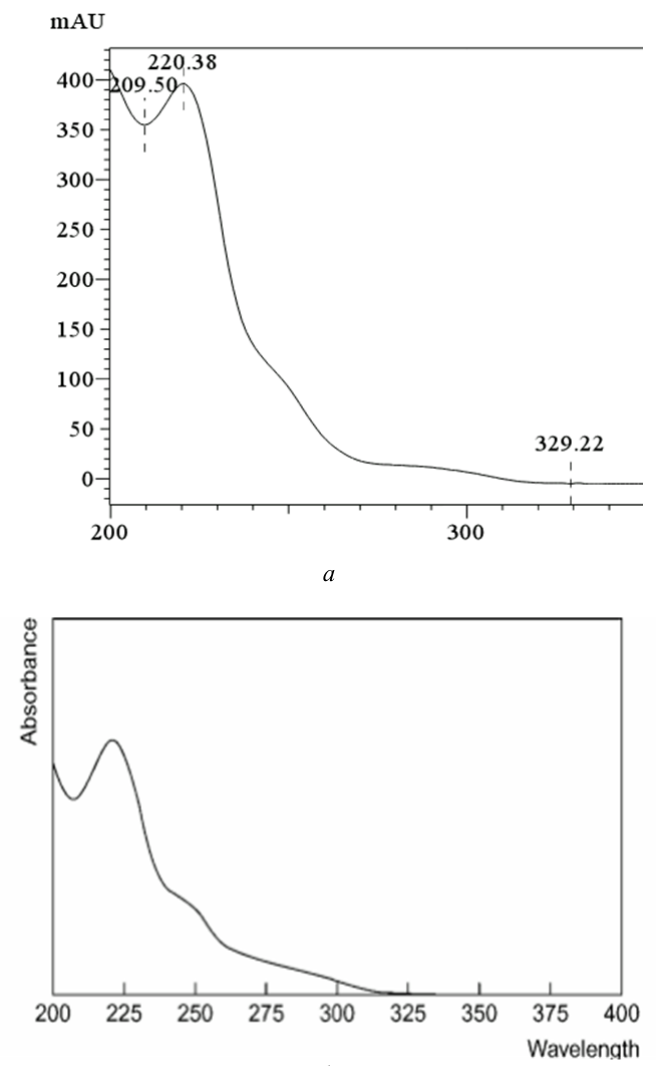
Fig. 4. Triazolam absorbance spectrum: a – obtained by measurement with DAD detector; b – obtained from